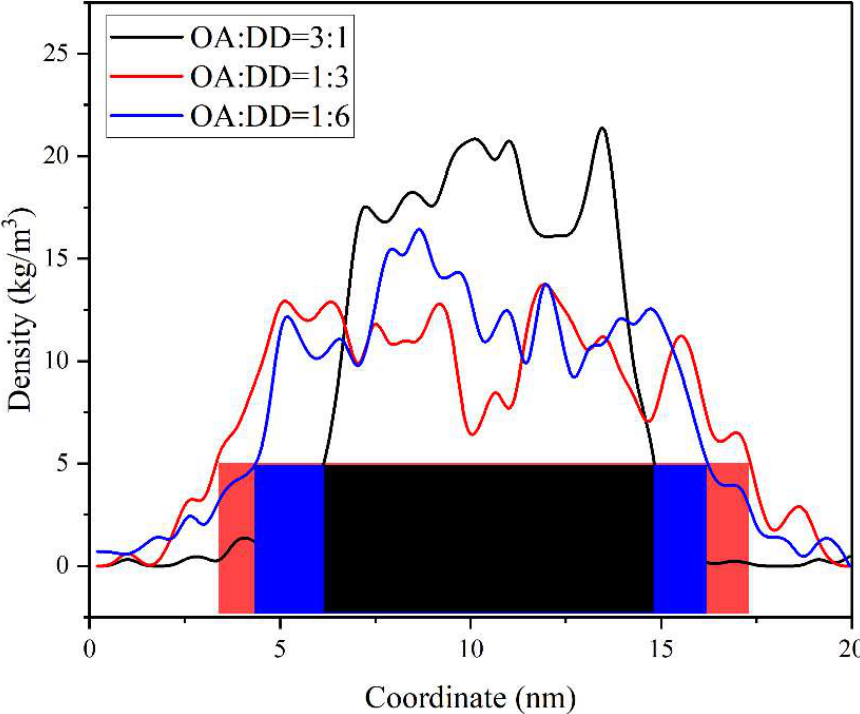
Figure 12. The concentration distribution of nitrogen molecules along the X axis in the adsorption configuration of bubbles on the oil film surface. To facilitate comparison, we moved the curve peak position to the middle position. The range of the color block is about equal to the maximum width of the bubble body, and the gas molecules outside it have separated from the main body.